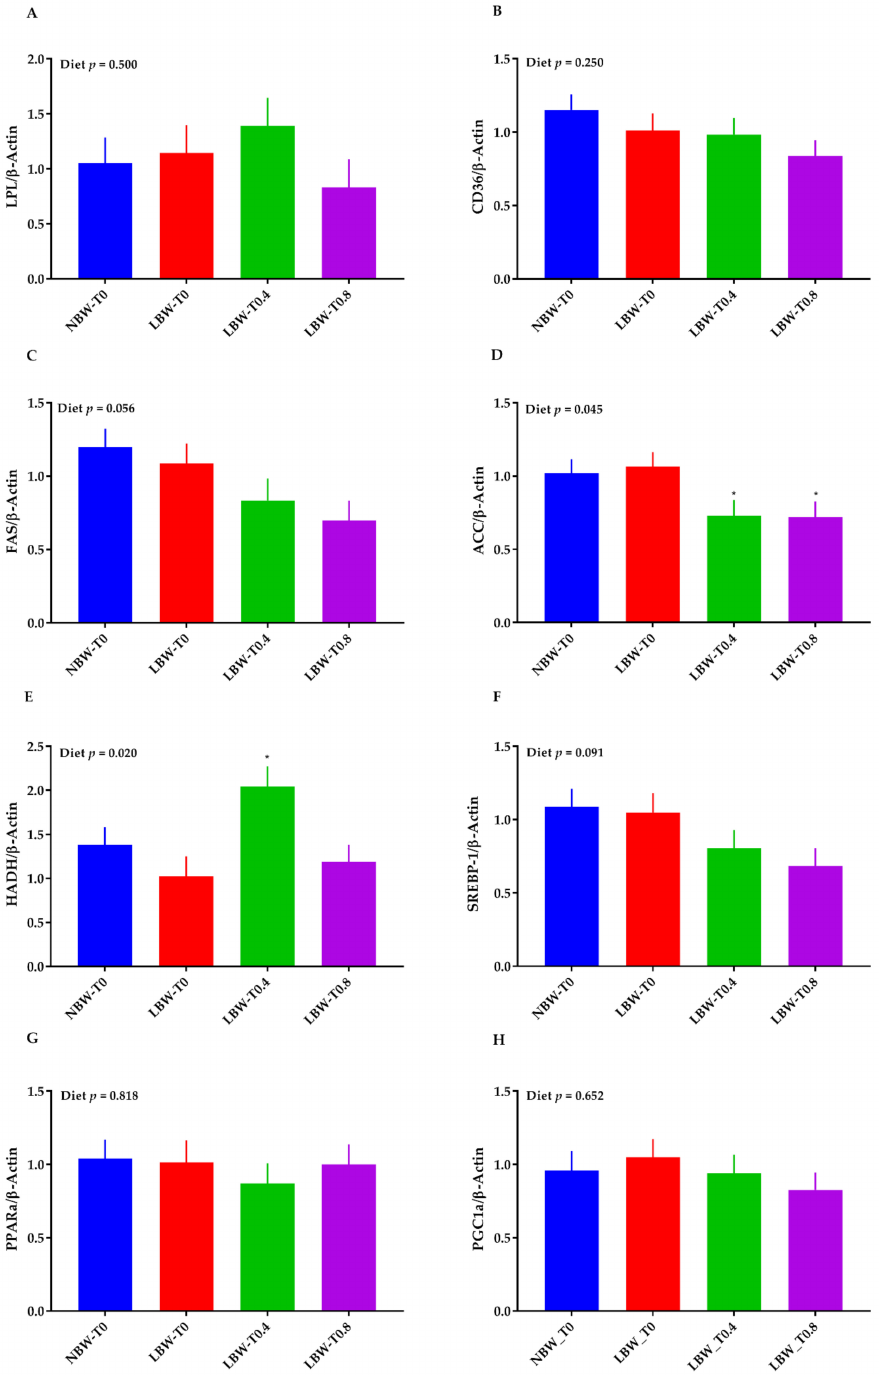
Figure 7. Effect of dietary L-tryptophan supplementation on the liver mRNA abundance of lipid metabolism markers in low-birthweight neonatal pigs. ( A ) lipoprotein lipase (LPL), ( B ) cluster of differentiation 36 molecule (CD36), ( C ) fatty acid synthase (FAS), ( D ) acetyl-CoA carboxylase alpha (ACC), ( E ) hydroxyacyl-CoA dehydrogenase (HADH), ( F ) sterol regulatory element-binding transcription factor 1 (SREBP-1), ( G ) peroxisome proliferator activated receptor alpha (PPAR α ), and ( H ) PPARG coactivator 1 alpha (PGC1 α ). NBW-T0, normal-birthweight piglets fed a basal diet without supplemented L-tryptophan (Trp); LBW-T0, low-birthweight piglets fed a basal diet without supplemented Trp; LBW-T0.4, low-birthweight piglets fed a diet supplemented with 0.4% Trp; and LBW-T0.8, low-birthweight piglets fed a diet supplemented with 0.8% Trp. n = 8 for NBW-T0, LBW-T0, and LBW-T0.8, and n = 7 for LBW-T0.4. * p ≤ 0.05 vs. LBW-T0. The values are the means ±